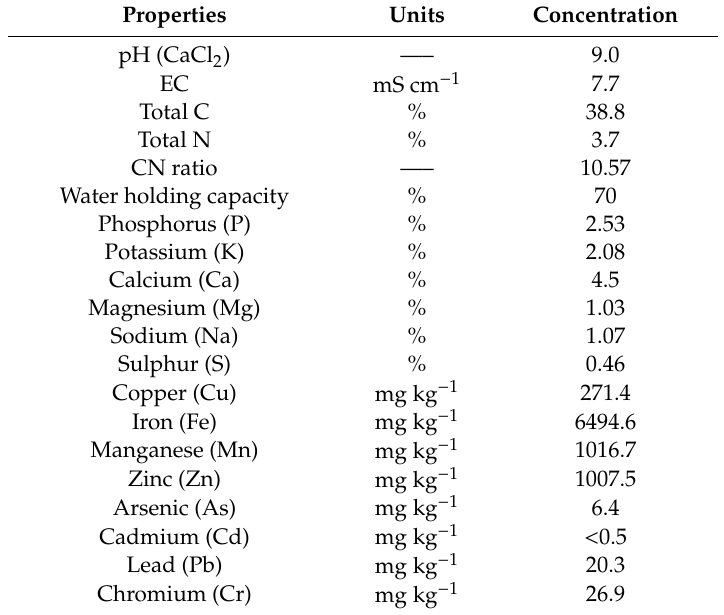
Table 1. Properties of biochar made from poultry litter feedstock used in this experiment. Note: EC, electrical conductivity; CN ratio, carbon nitrogen